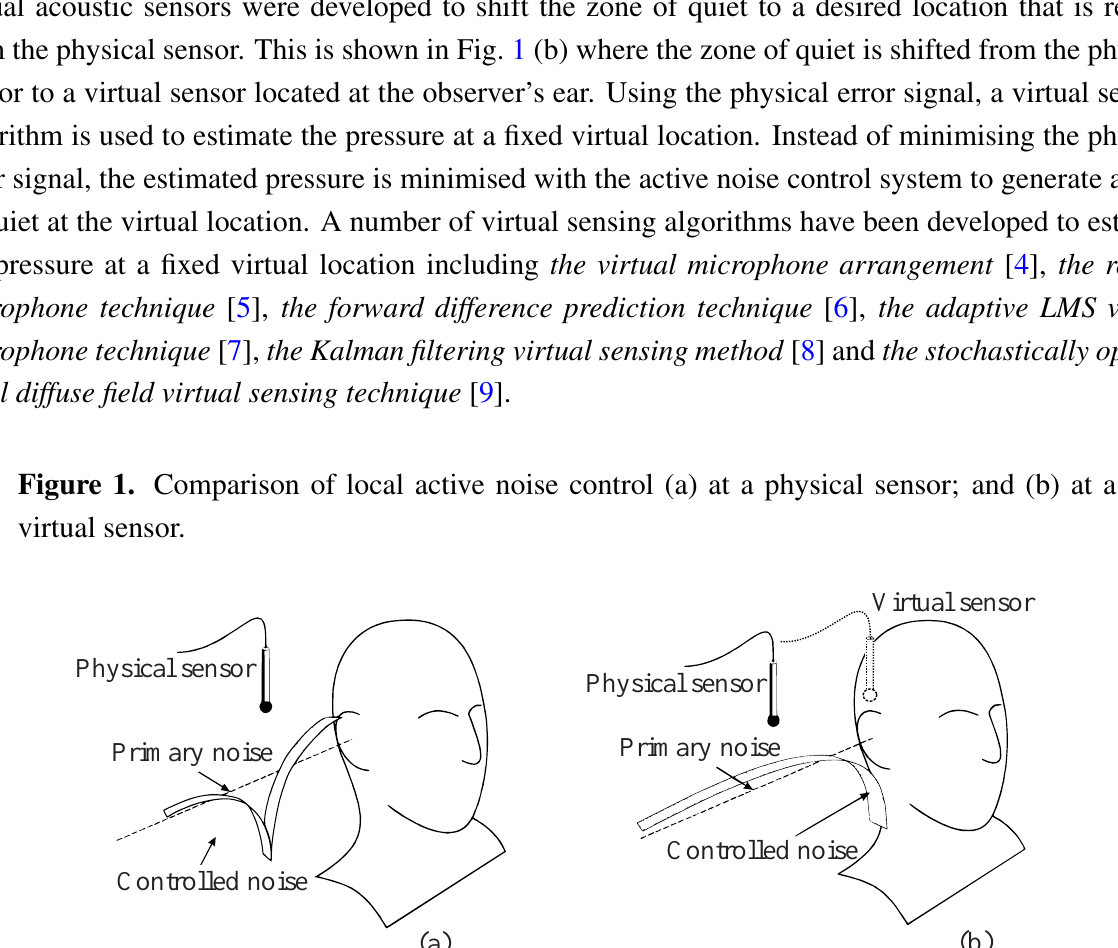
Figure 1 . Comparison of local active noise control (a) at a physical sensor; and (b) at a virtual